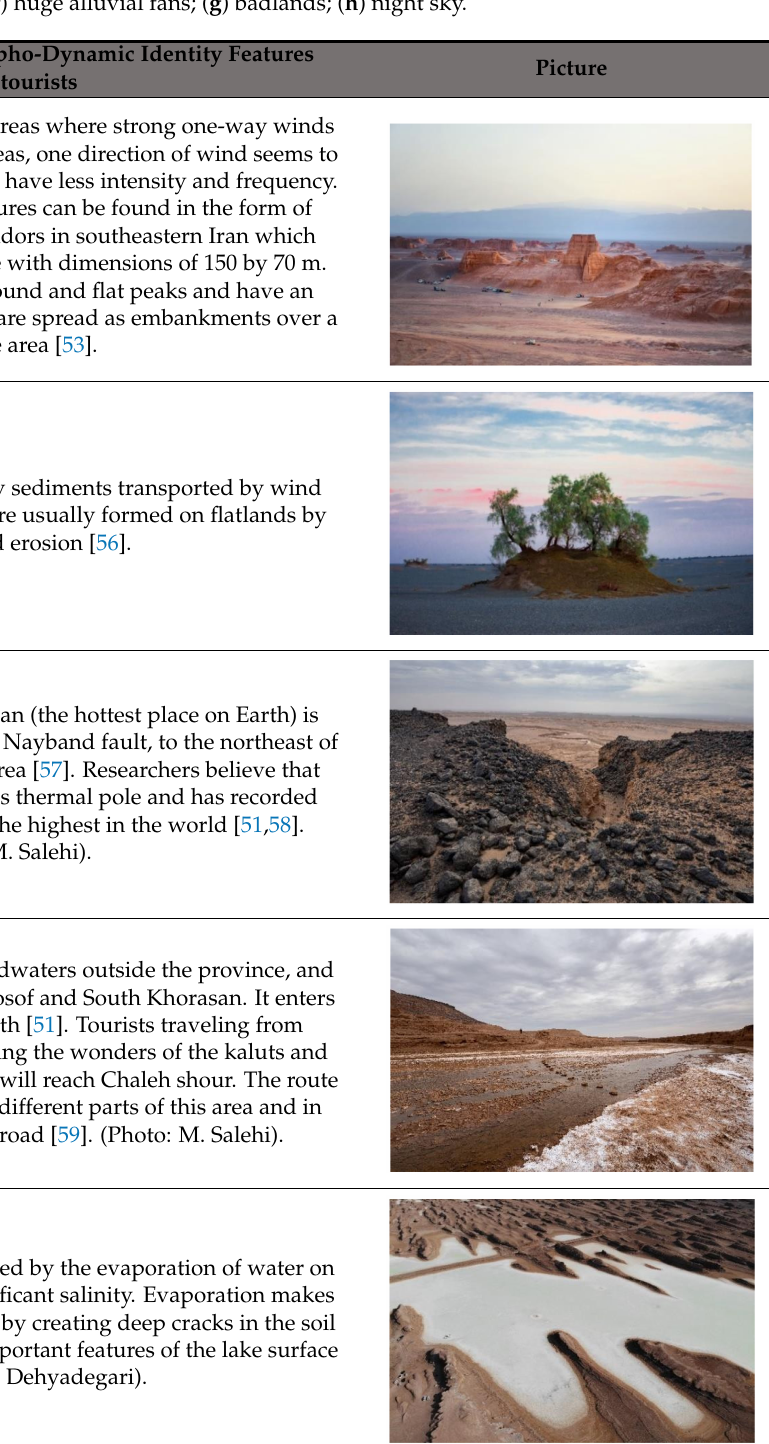
Table 2. Geosites of Shahdad in Iran: ( a ) kalut; ( b ) nebkha; ( c ) Gandom Beryan; ( d ) Salty River;